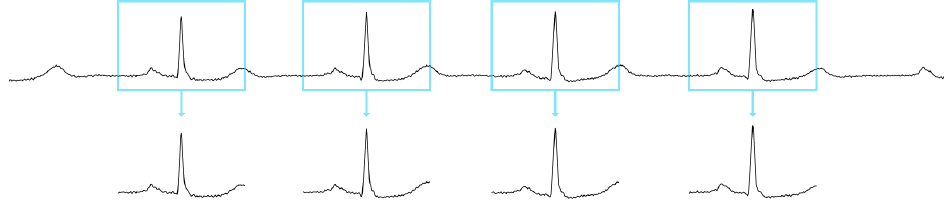
Figure 7. ECG signal snippet and windows containing extracted heartbeats.